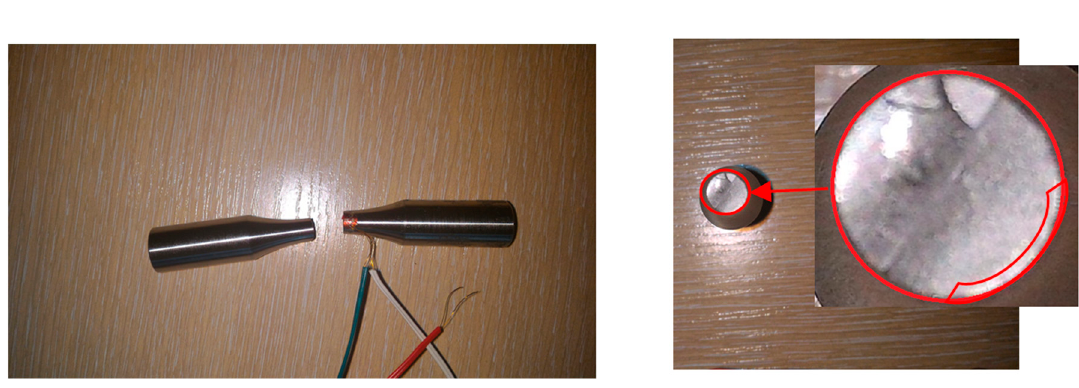
Figure 9. Scrap obtained during random bending tests with a crack initiation site.